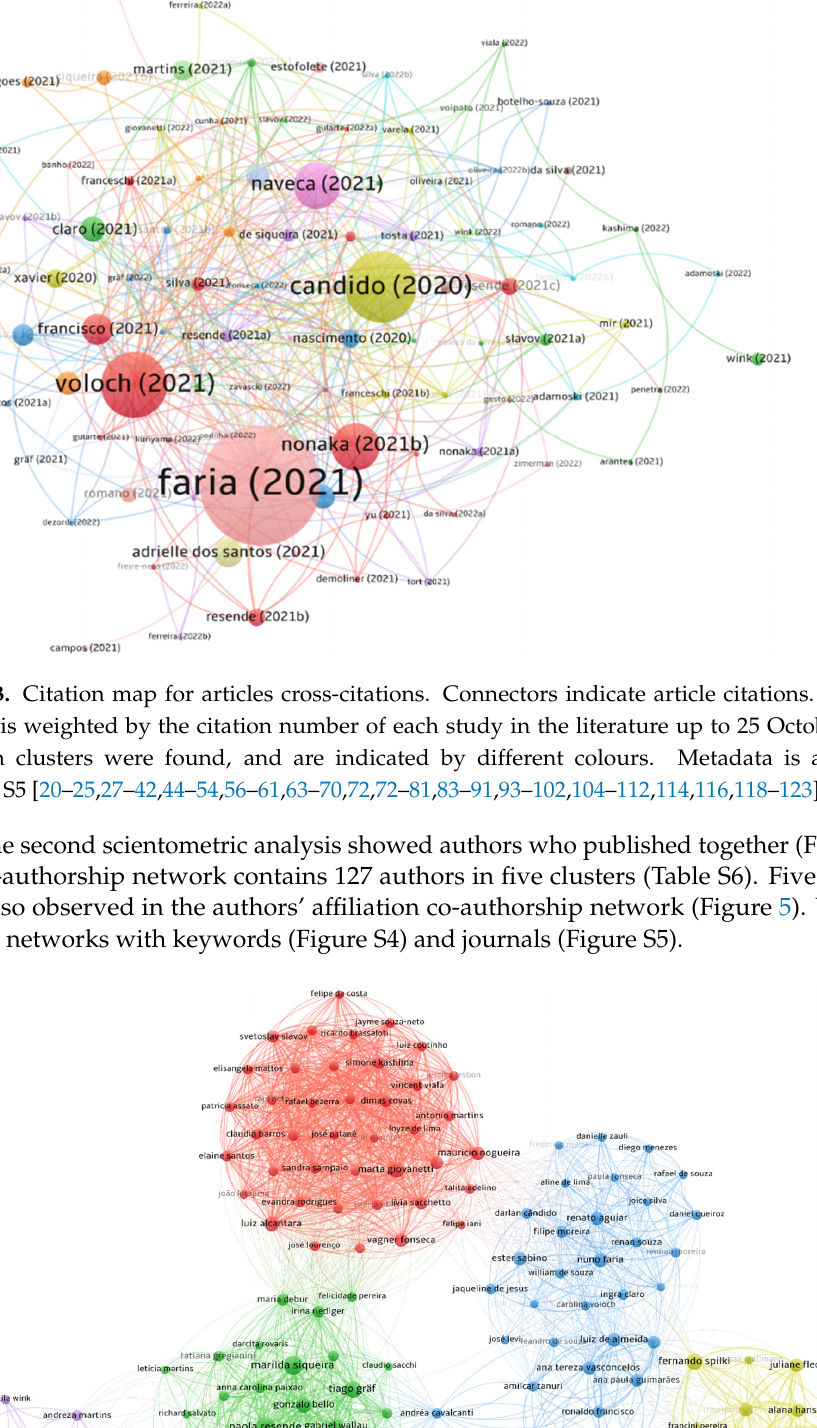
Figure 5. Organisation co-authorship map. Organisations with at least three articles in the systematic review were included ( n = 63 out of 229). Connectors indicate co-authorship. The number of included articles from each organisation weighted circle sizes. Five clusters were found, and are indicated by different colours. Metadata is available in Table S7.